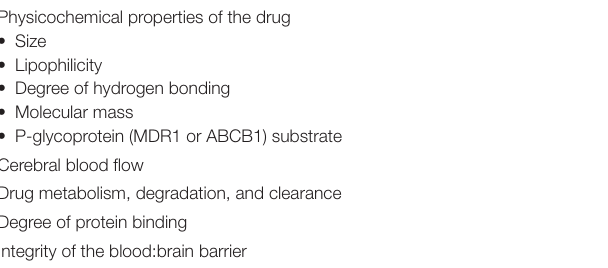
TaBle 2 | Determinants of central nervous system penetration.